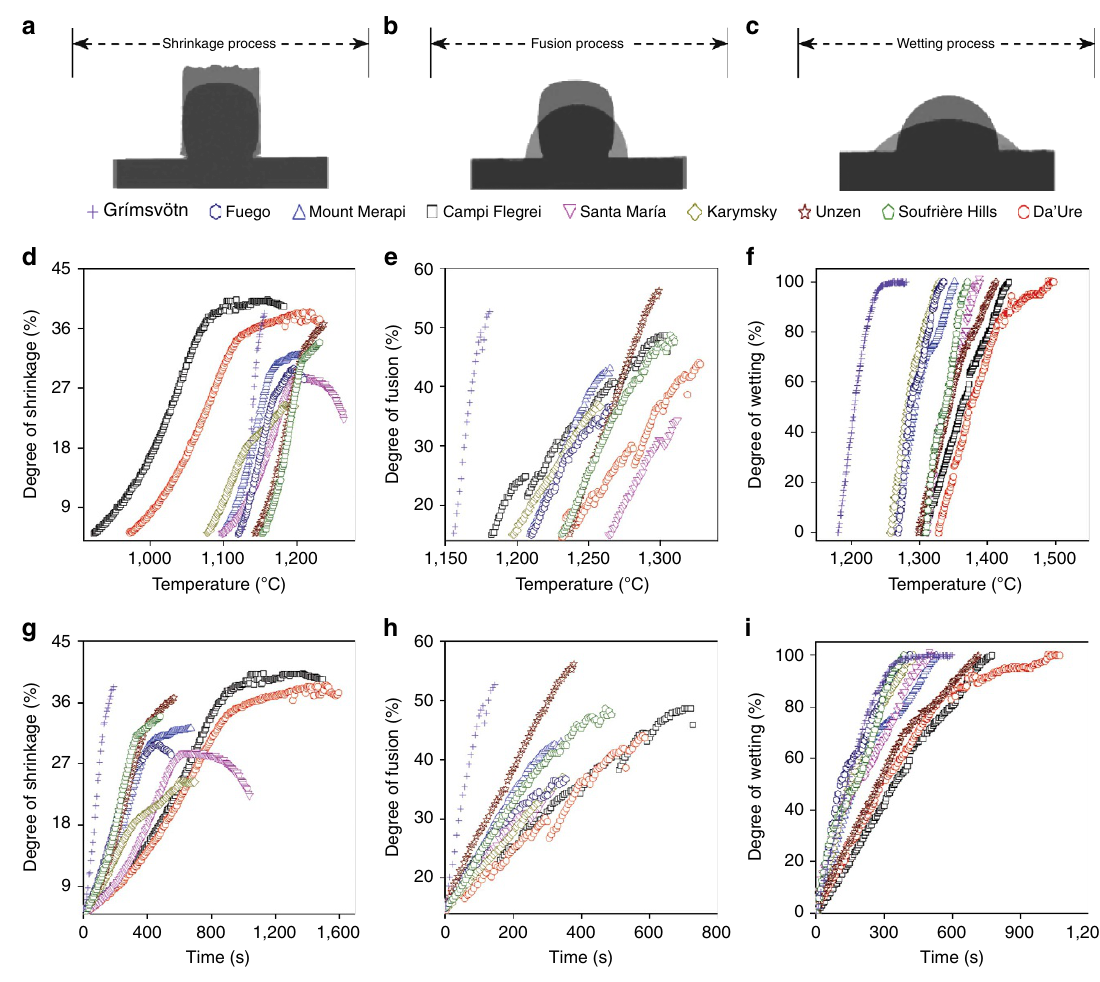
Figure 3 | Geometrical evolution of volcanic ash compacts. Typical shape changes during heat through the stages of ( a ) shrinkage, ( b ) fusion and ( c ) wetting. In this example, the shape of volcanic ash compact from Fuego is shown. The morphological evolution is quantified as a function of ( d – f ) temperature and ( g – i )